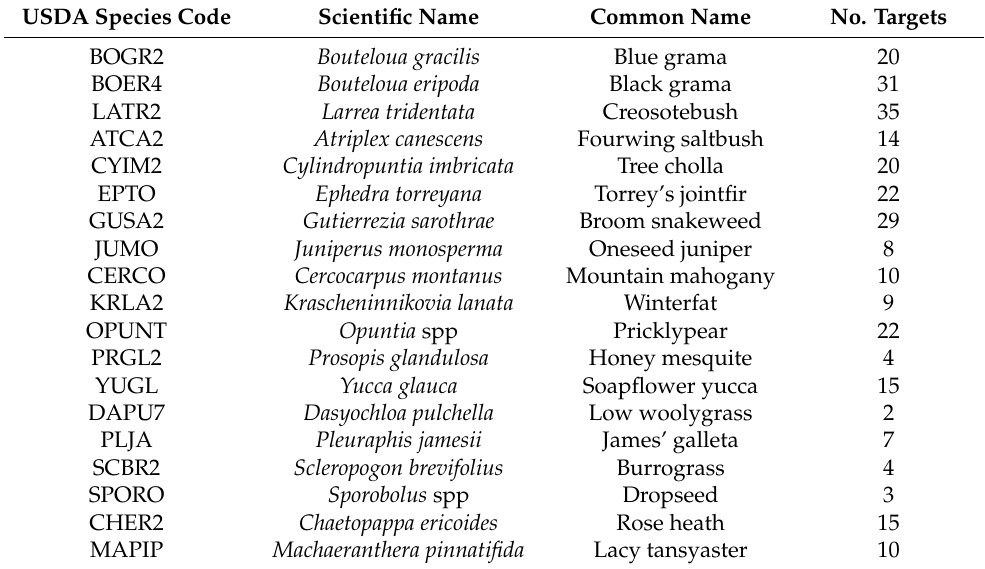
Table 1. Vegetation species sampled at the SNWR USDA Species